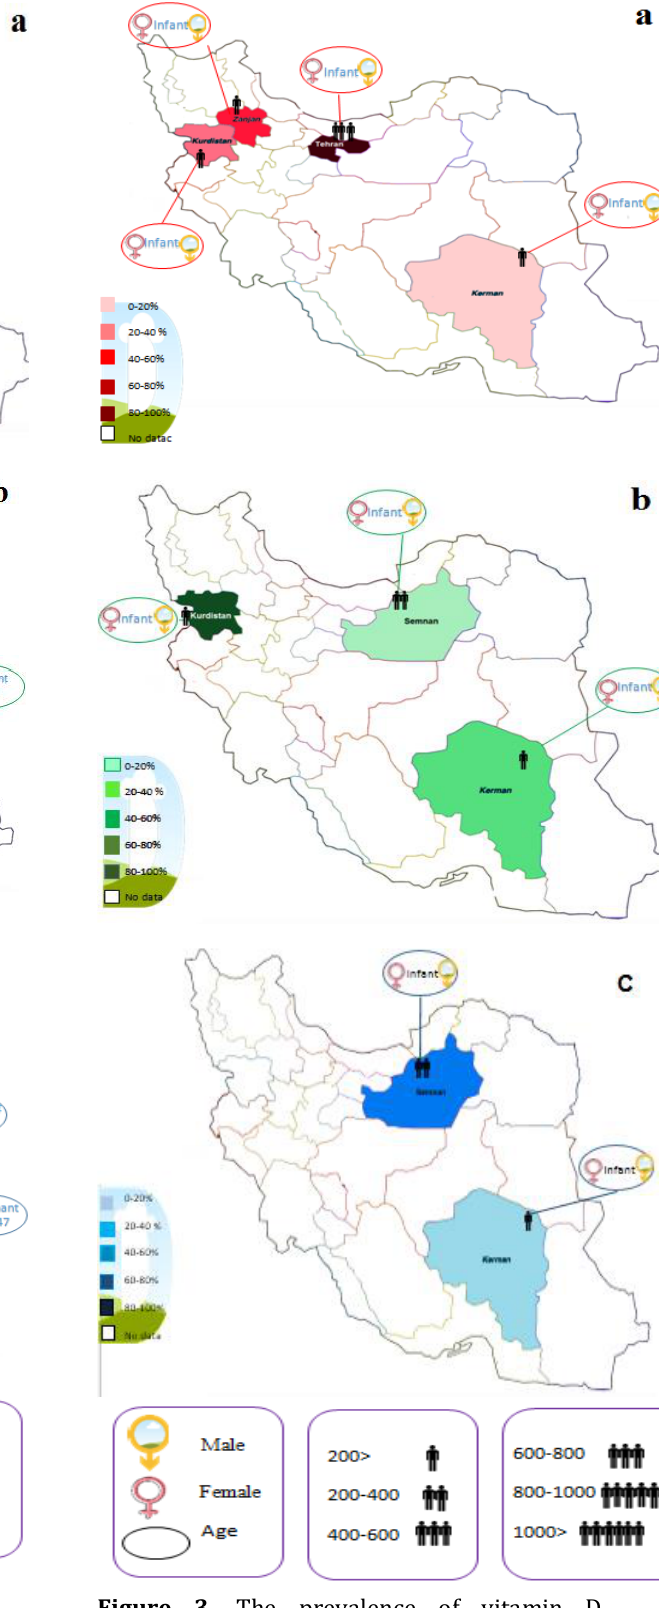
Figure 2 . The prevalence of vitamin D deficiency in Iranian pregnant women using cut- off values of 12 and 20 as well as prevalence of 25- (OH)-D levels <30 ng/ml (a, b, c, respectively)